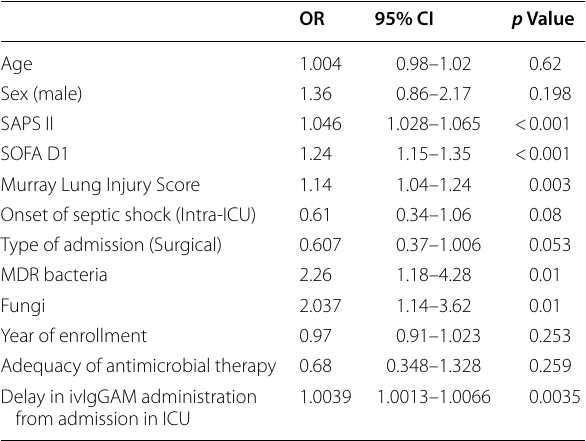
Table 2 Univariable logistic regression analyses of risk factors for in-ICU mortality